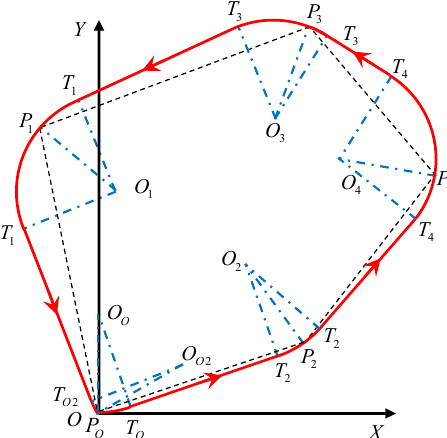
Figure 6. Schematic diagram of optimal route. P O is the take-off and landing point of the HSA, P 1 , P 2 , P 3 , P 4 are the input multi-mission points, P O → P 2 → P 4 → P 3 → P 1 → P O is the optimal flight sequence based on the genetic algorithm, and the red line is the optimal route obtained by the route planning method based on the greedy strategy.